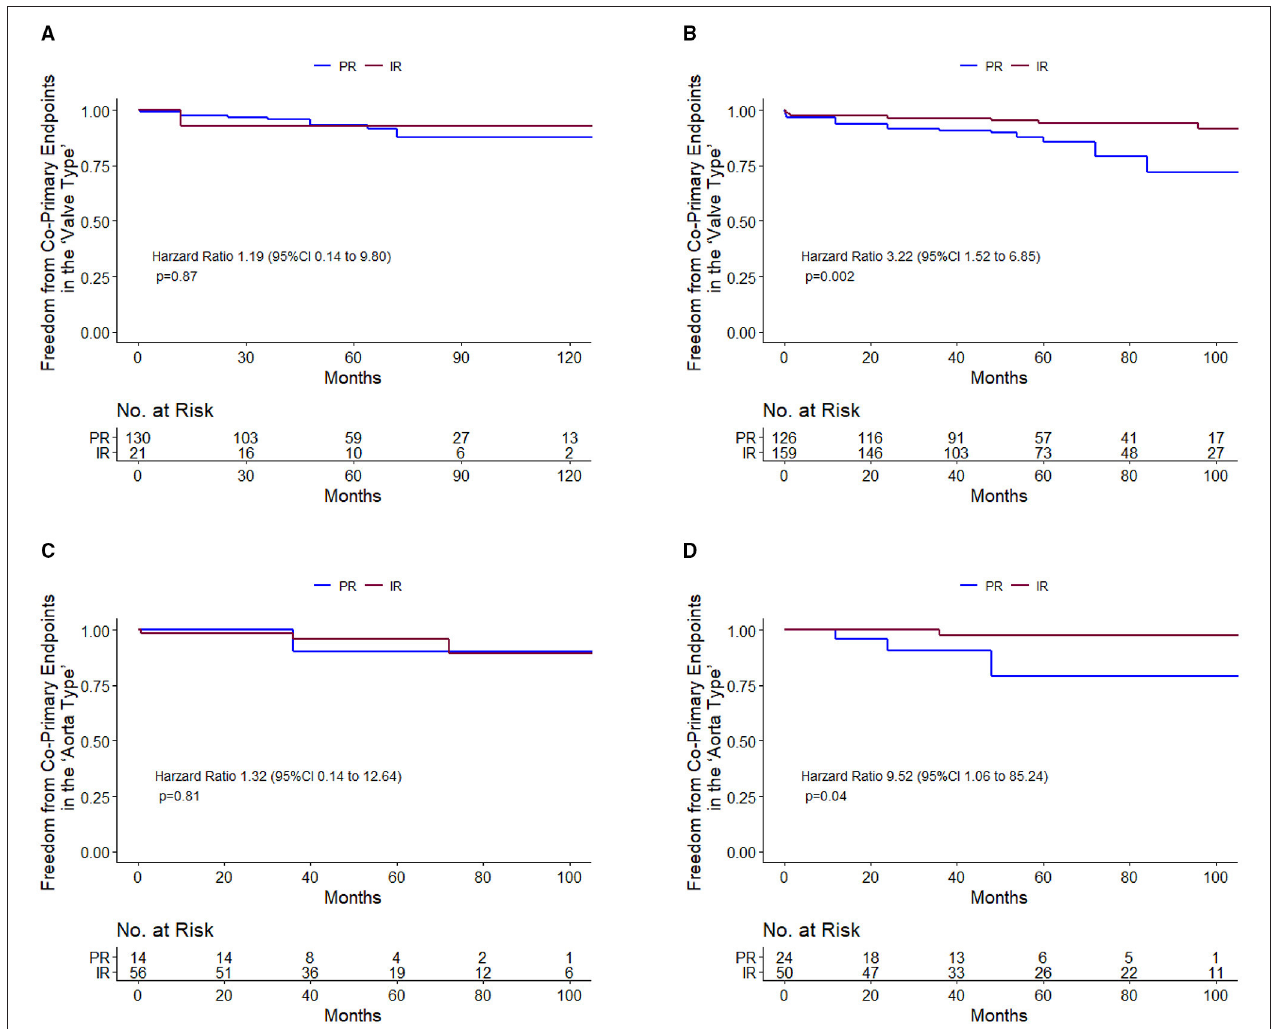
FIGURE 3 | Primary endpoint survival curves for freedom from death and reoperation. 35–40mm in valve type (A) ; > 40mm in valve type (B) ; 45–52mm in aorta type (C) ; and 52–60mm in aorta type (D) .